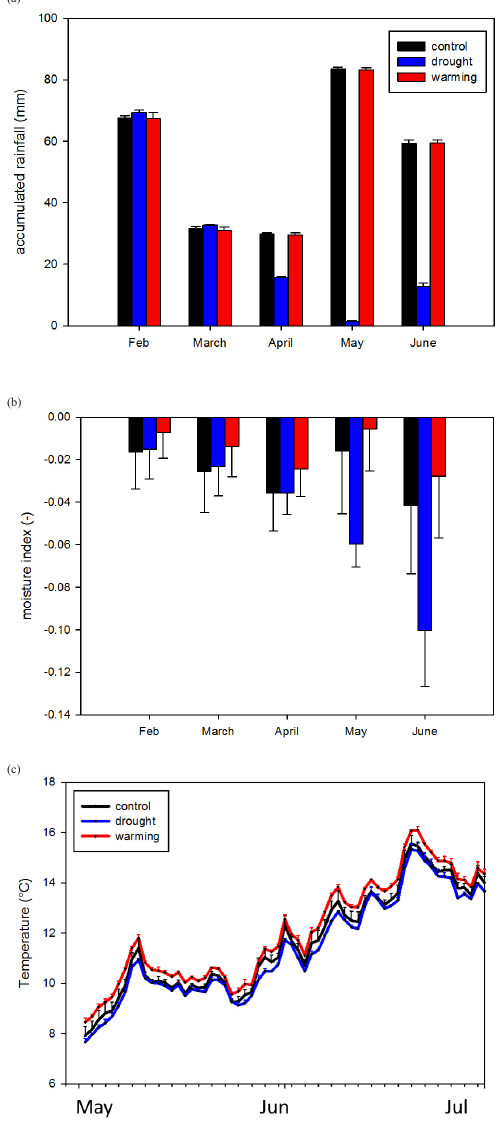
Figure 2. Climatic data for the treated plots control (black), drought (blue) and warming (red): (a) precipitation (accumulatedmm rain- fall for the given month), (b) soil moisture (index) for 0 to 5cm depth and (c) temperature in the soil for 0 to 5cm depth. This year drought treatment started 15 April and ended 22 June 2013. Soil was sampled from all plots on 23